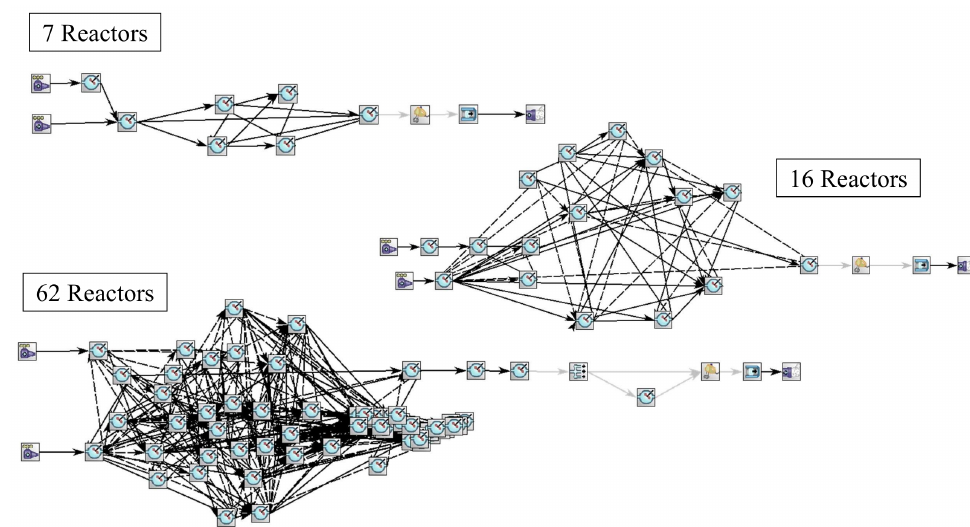
Figure 11. FLOX ® ERNs with different numbers of PSR reactors, automatically constructed in Ansys